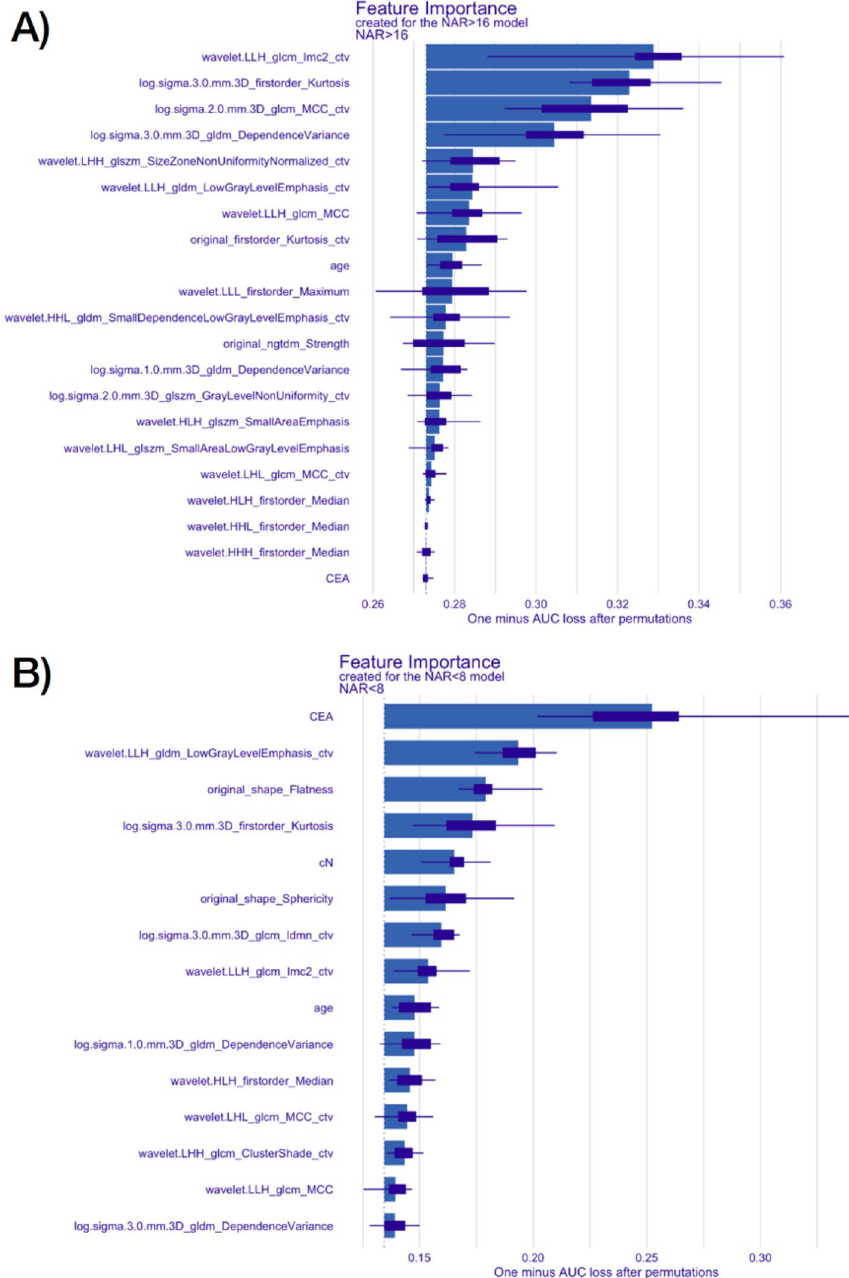
segmentation while those without are extracted from the GTV